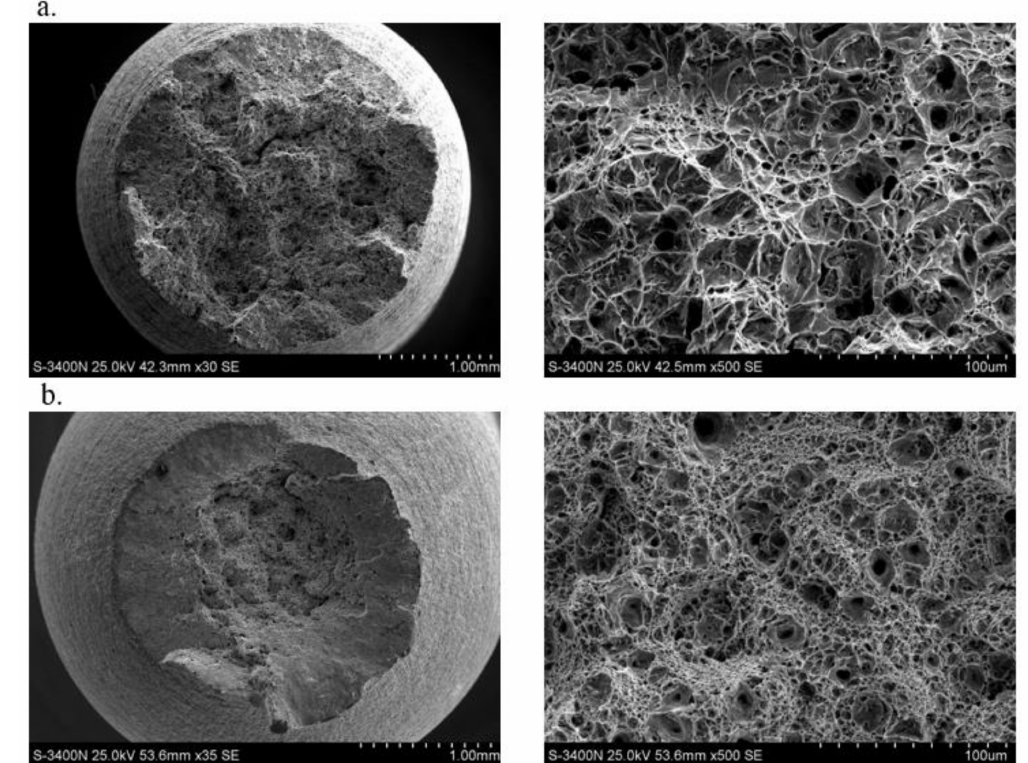
Figure 12. Specimen fractures after dynamic tension with the linear rate of the impact hammer v = 30 m/s for steels: ( a ) TRIP; ( b ) DP.